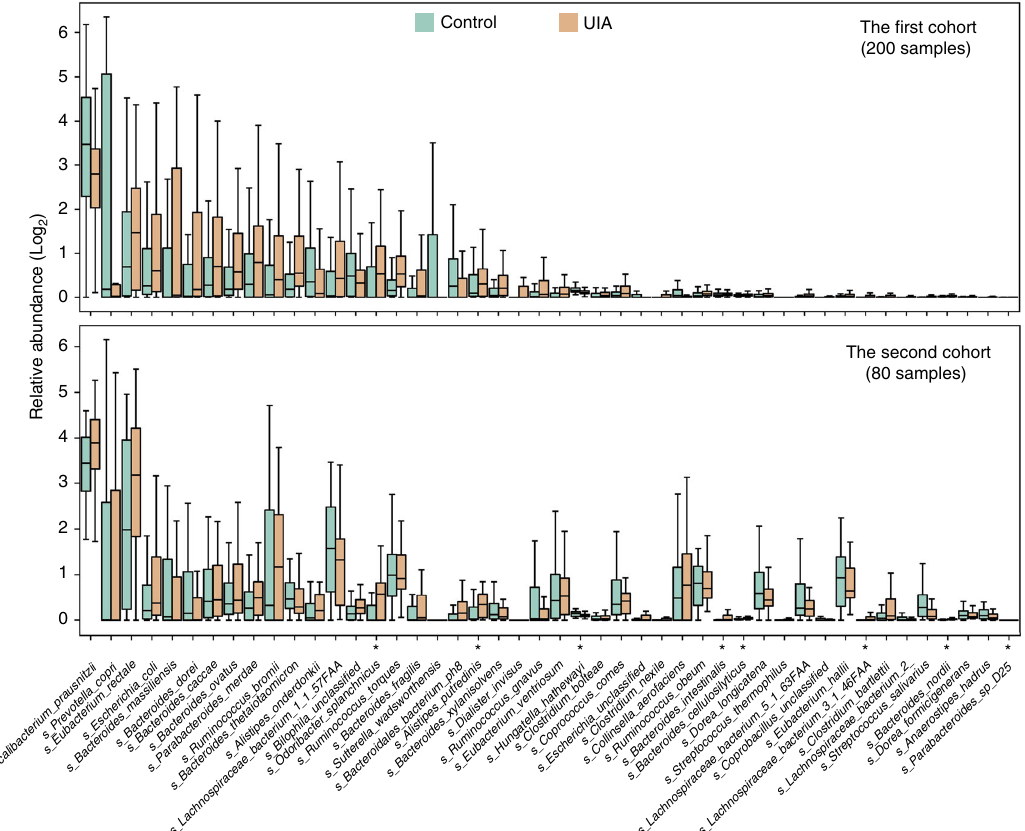
Fig. 2 Alterations of gut microbial species in UIA patients. Turquoise and orange, abundance of control- and UIA-enriched species; * P < 0.05, for both the fi rst ( n = 100) and second cohorts ( n = 40) (two-tailed Wilcoxon rank-sum test). In all box plots, boxes represent the interquartile ranges (IQRs) between the fi rst and third quartiles, and the line inside the box represents the median; whiskers represent the lowest or highest values within 1.5 × IQR from the fi rst or third quartiles. Source data are provided as a Source Data fi le.